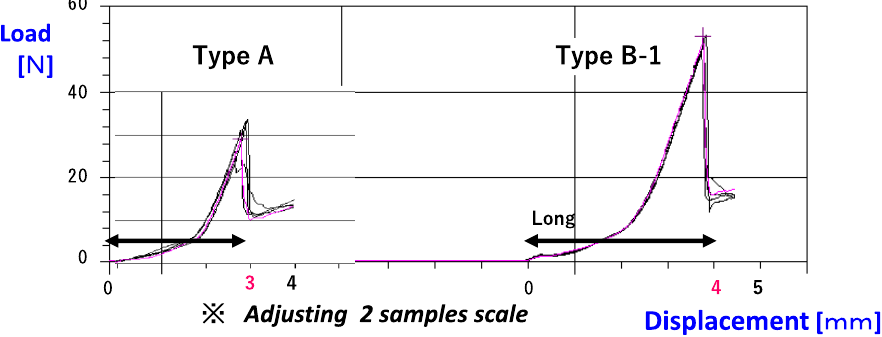
Figure 2. Load profile of samples A and B1. This profile was measured by a FORCE TESTER MCT-